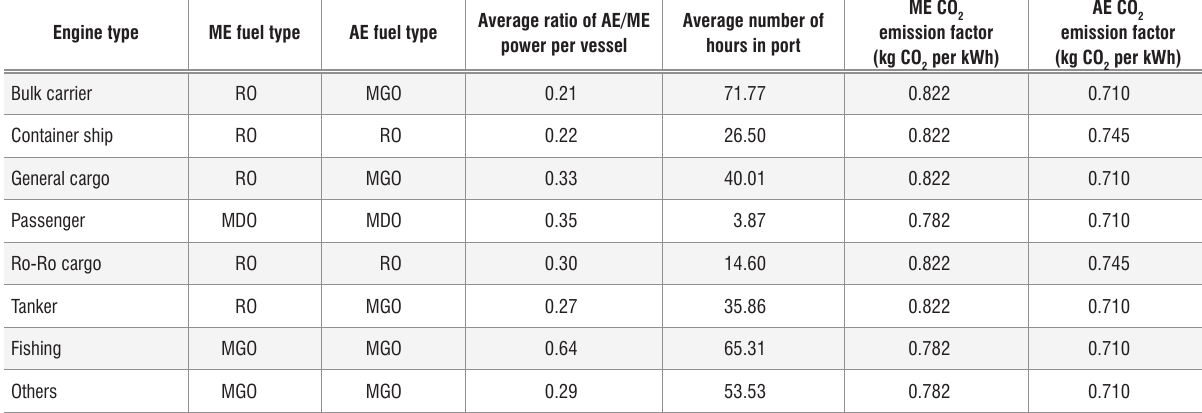
Estimates, per vessel type, of fuel types, the average ratio of the power output of the auxillary engine (AE) to the main engine (ME), the average number of hours spent in port, and the CO emission factors for the ME and 2